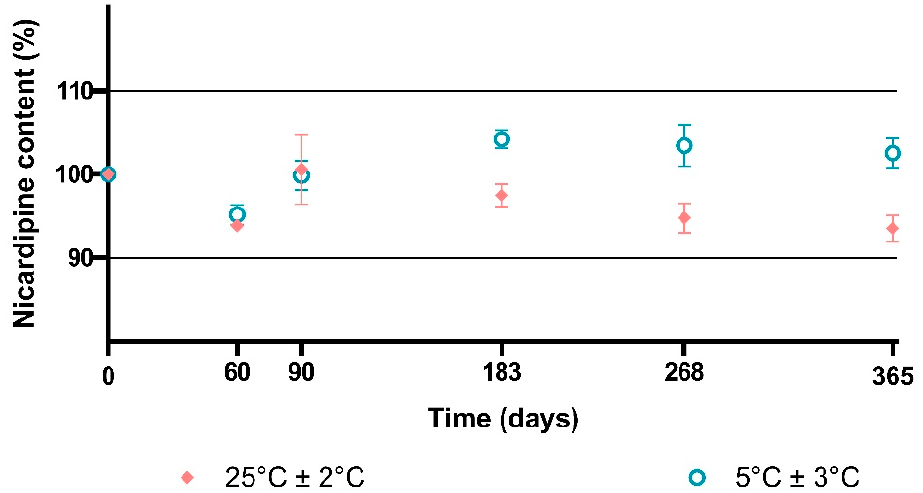
Figure 4. Chemical stability of nicardipine hydrochloride in compounded oral solution at 2 mg/mL for 365 days. Note: Results are expressed as the mean of the nine samples (three test samples for each of the three batches), and error bars are defined as SD.